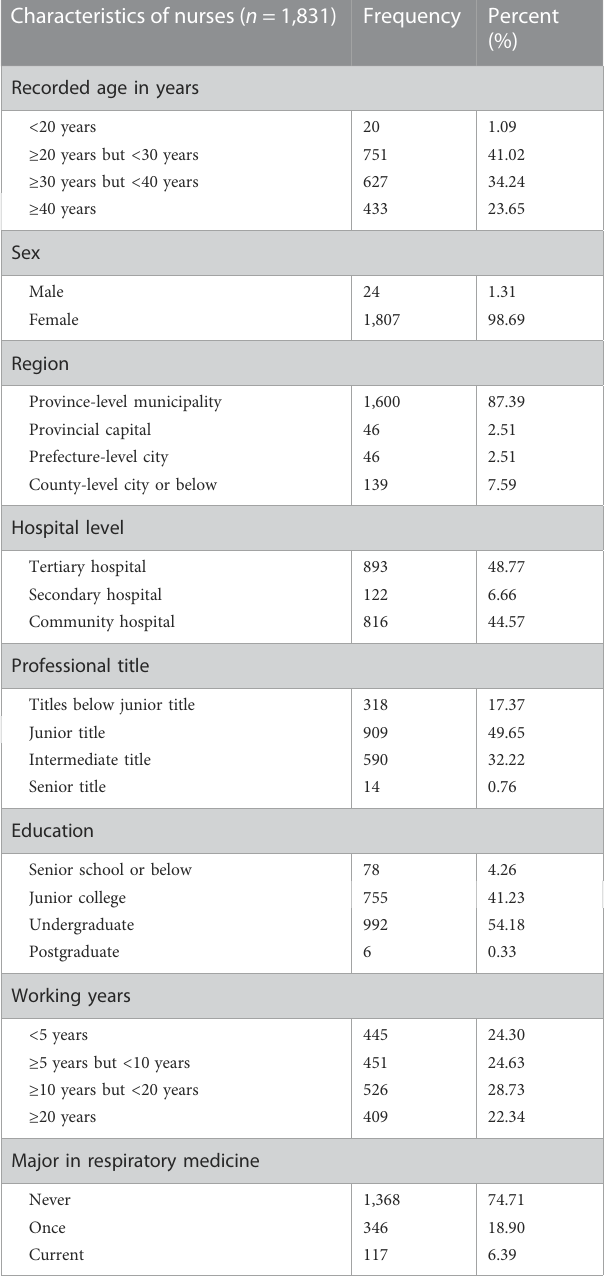
TABLE 1 Sociodemographic characteristics of